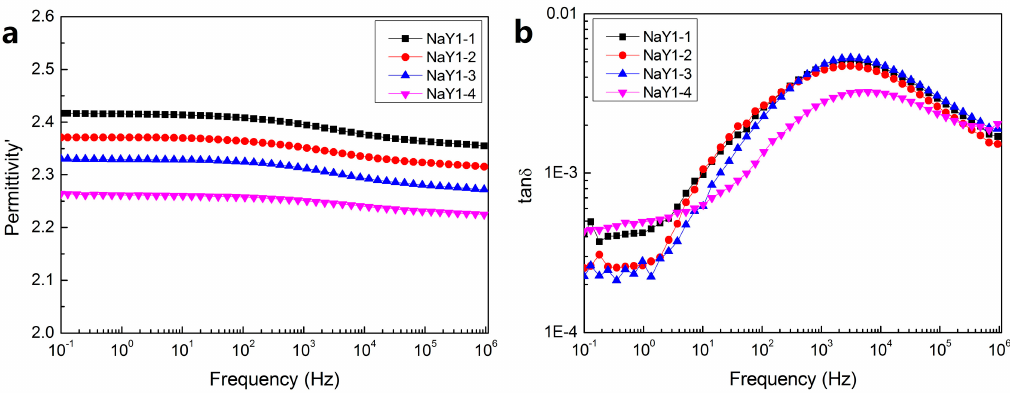
Figure 6. Dielectric spectrum of zeolite/LDPE nanocomposite with nano-zeolite doping concentration 1 wt % for dielectric constant ( a ) and dielectric loss ( b